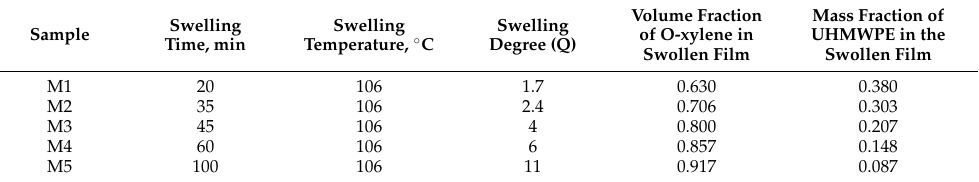
Table 1. The parameters of the membrane preparation